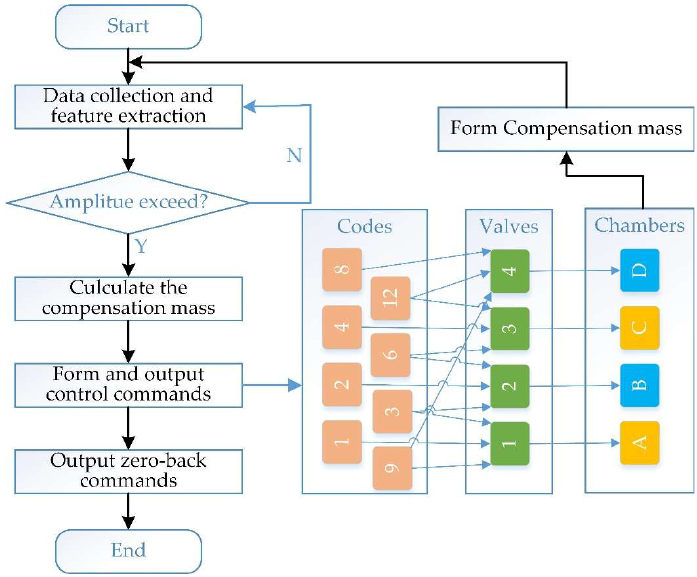
Figure 9. diagram of the control program. Figure 9. Diagram of the control